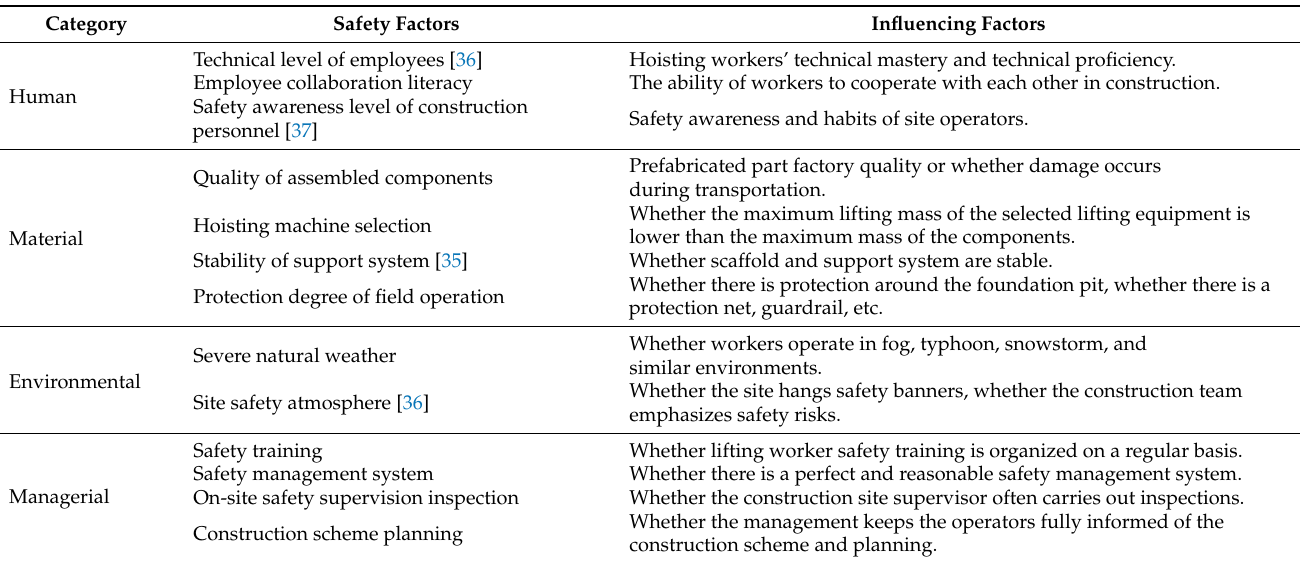
Table 6. Safety-influencing factors in hoisting operations of prefabricated buildings.